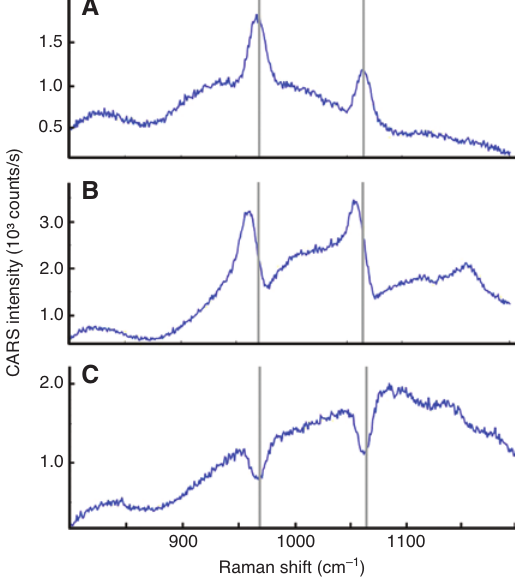
Figure 10: SE-CARS spectra obtained near the 968 and 1064 cm −1 modes of pyridazine near a layer of aggregated colloidal gold particles. As the probing spot was moved over the sample, differences in the lineshapes of the two modes were observed, varying from positive peaks (A), to dispersive lineshapes (B), to dips (C) relative to an electronic FWM background. Adapted with permission from Ref.